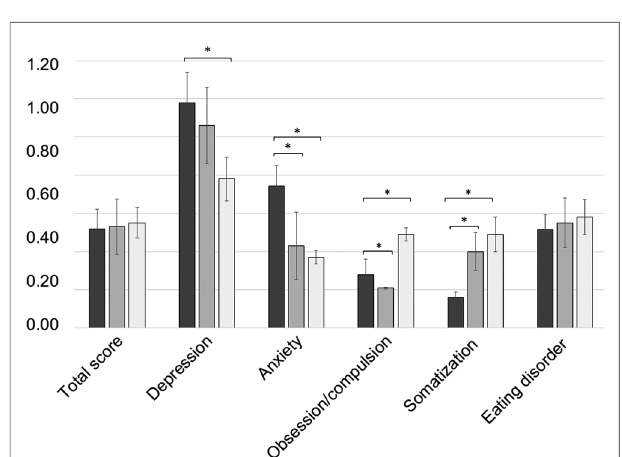
FIGURE 6 | Mean values of the ISR (ICD-10-based symptom rating) total scores and depression, anxiety, obsession/compulsion, somatization, and eating disorder of the subdimensions. The values of the study cohort are shown in dark gray. For a comparison, the values of the successfully treated PJI population are illustrated in gray, and the values of the successfully treated FRI population are in light gray. * illustrates statistical signi fi cance on a p <0.05 level determined by an independent t